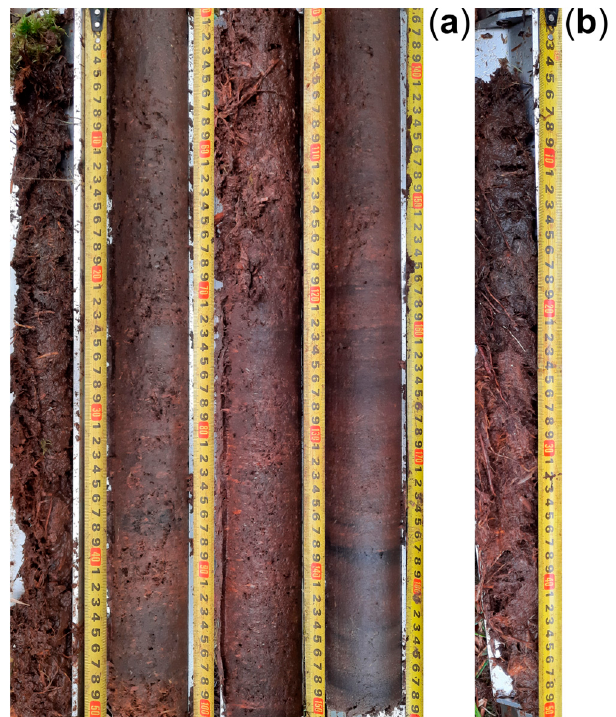
Figure 2. Images of ( a ) the undisturbed peat core and ( b ) the floating mat deposits (the top part of fresh and loose Sphagnum stems was sampled with scissors) from the Gorenki mire.